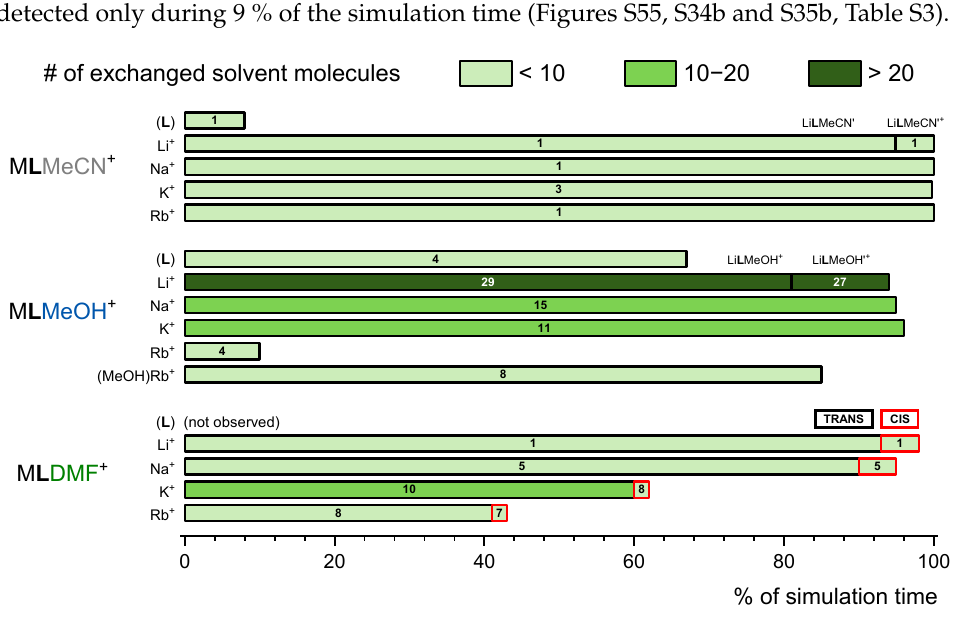
Figure 6. Inclusion of solvent molecules in the hydrophobic cavity of receptor L and its complexes observed by MD simulations ( t tot = 50 ns). Fractions of the simulation time corresponding to solvent- adduct existence, number of solvent molecules included, and their orientation. Species marked by apostrophe denote those in which cations are additionally coordinated by solvent molecules. In the case of DMF, TRANS, and CIS, marks indicate positions of the methyl group relative to the oxygen atom.